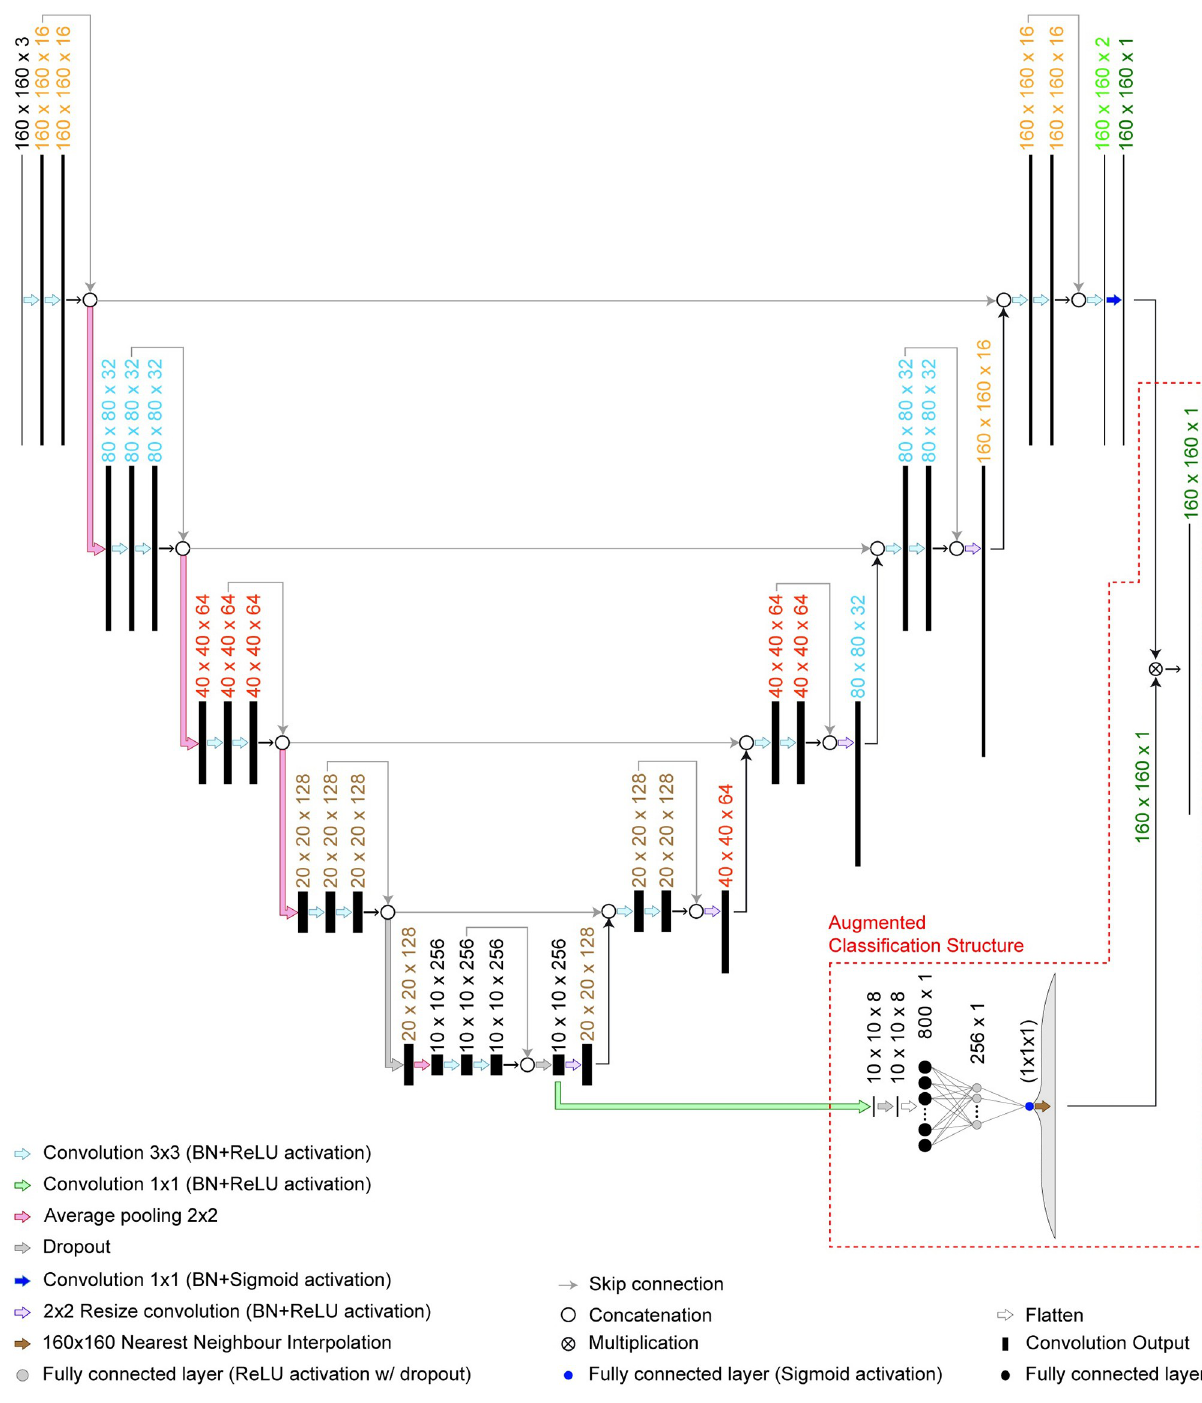
Fig 6. Proposed network architecture with augmented classification structure.